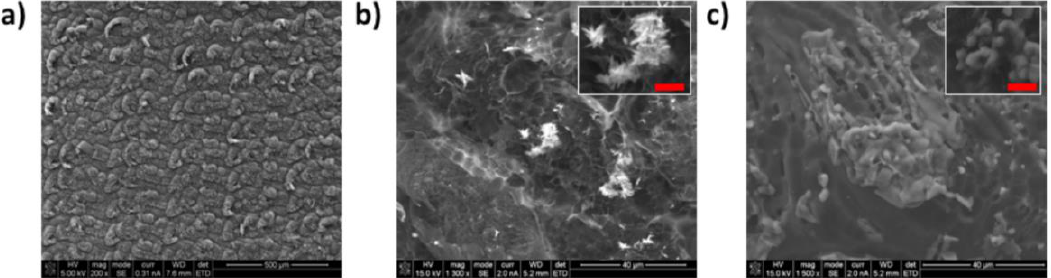
Figure 2. Morphological characterization of LSG electrodes. ( a ) Low magnification SEM of LSG, prior to metallization with copper; ( b ) high resolution SEM of electrode metallized with CuSO 4 ; inset shows magnification of a copper microparticle (scale bar represents 5 µm); ( c ) high resolution SEM of electrode metallized with locally sourced material; inset shows magnification of a copper microparticle (scale bar represents 5 µm).